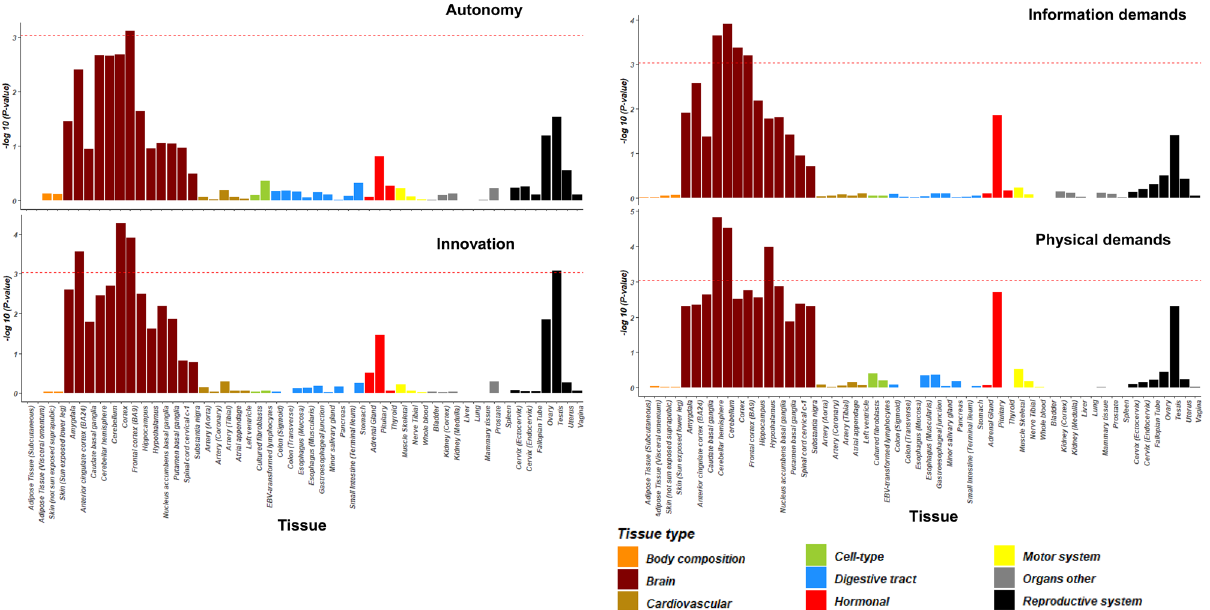
Figure 2. Enrichment of gene expression in tissues for autonomy, innovation, information demands, and physical demands. The x axis presents 54 specific tissues (the tissue order is the same for each sub-plot), and the y axis presents − log 10 P values for enrichment of implicated genes in specific tissues for job attainment characteristics. Colors represent a broad category of different tissue types. The horizontal red dashed line represents a Bonferroni significance level of P < 9.26 × 10 –4 ; the detailed information on beta effects in Supplementary Table